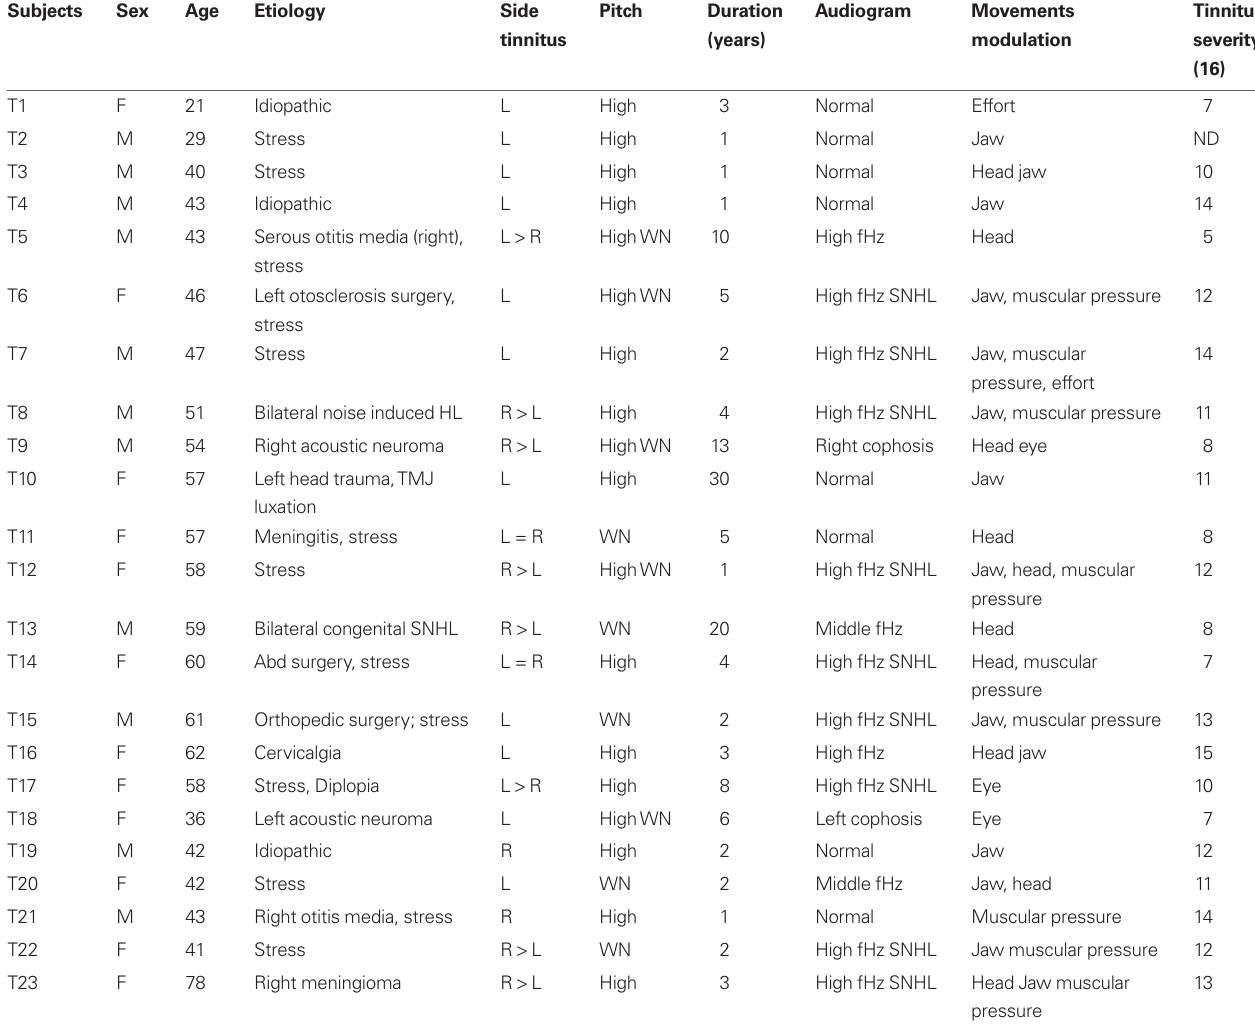
Table 1 | Clinical characteristic of tinnitus